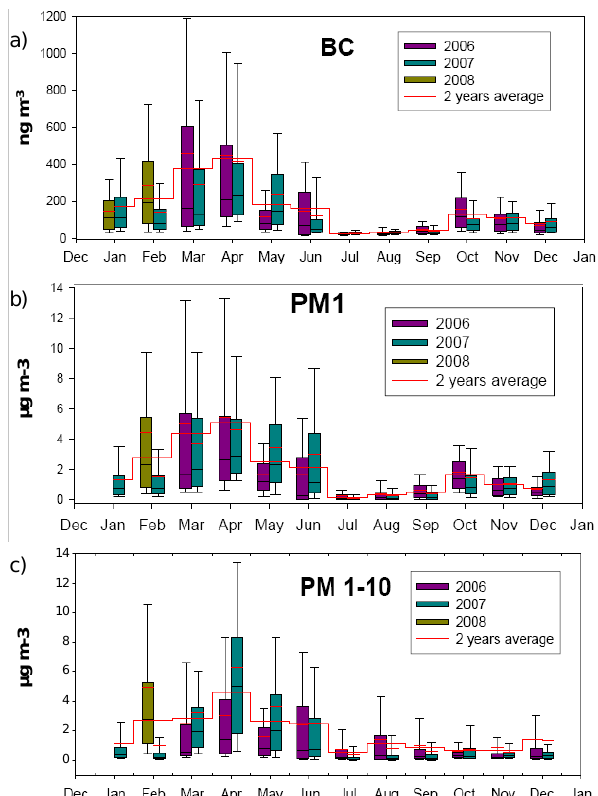
Fig. 2. Monthly averages (black line within the boxes), medians Fig. 38. Observations at the Nepal Climate Observatory-Pyramids (red line within the boxes) and percentiles (10-25-75-90, boxes and of (a) BC, (b) PM1, (c) PM1-10; the 30-min measurements are pre- whiskers) of 30-min PM 1 (a) , PM 1 − 10 (b) and BC (c) at NCO- sented as monthly averages (black line within the boxes), medians P. The continuous red lines represent the 2 year averaged monthly (red line within the boxes) and percentiles (10-25-75-90, boxes and behaviours. whiskers), with the continuous red lines representing the 2 year av- eraged monthly data. (from Marinoni et al., 2010, copyright 2010 by the European Geophysical Union, reproduced with